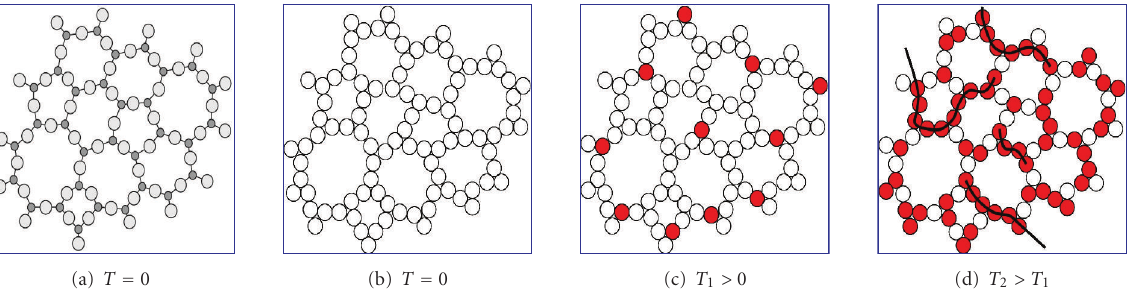
Figure 11: Schematic of disordered bond lattice model of an amorphous material: (a) distribution of atoms in amorphous phase at T = 0; (b) distribution of bonds in amorphous phase at T = 0; (c) distribution of bonds in amorphous phase at T 1 > 0; (d) distribution of bonds in amorphous phase at higher temperatures T 2 > T 1 when configuron clustering occurs.